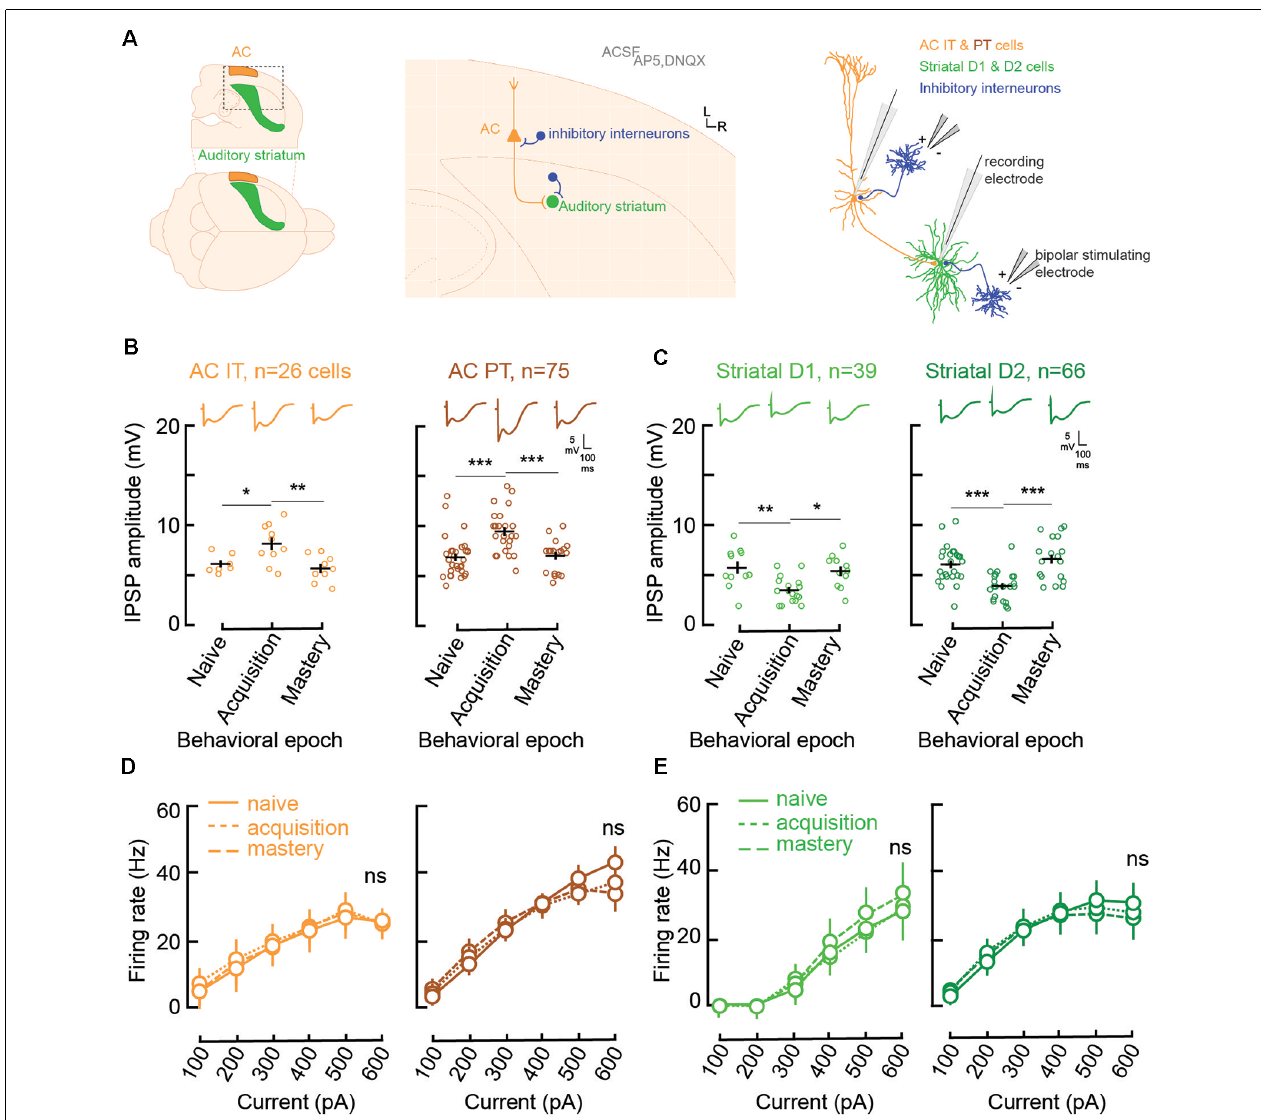
FIGURE 2 | Learning is accompanied by changes in both AC and striatal GABAA inhibitory strengths. (A) Illustration of slice preparation for recordings in AC layer 5 IT and PT cells, and striatal D1 and D2 MSNs. Whole-cell current was used to measure inhibitory postsynaptic strength (IPSP) amplitudes and evoked firing rates (see “Materials and Methods” section). (B) Individual (open circles) and mean ( ± SEM, black lines) maximum evoked IPSP amplitudes in AC layer 5 IT and PT cells from normal-hearing gerbils ( n = 23) previously trained until their performance matched one of three behavioral epochs: naïve (d (cid:48) < 1), acquisition (d (cid:48) between 1 and 2), and mastery phase (d (cid:48) > 2). Representative traces are shown at the top. (C) Individual and mean ( ± SEM) IPSP amplitudes in striatal D1 and D2 cells as a function of behavioral epochs. (D) Input-output functions (firing rate patterns; mean ± SEM) for IT and PT cells as a function of behavioral epochs. (E) Input-output functions for striatal D1 and D2 cells as a function of behavioral epochs. Asterisks denote statistically significant differences at the following levels: * p < 0.05, ** p < 0.01, *** p < 0.001, and ns = not